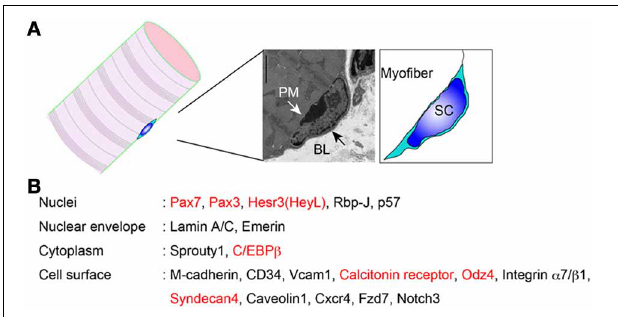
FIGURE 1 | Proteins expressed in quiescent muscle satellite cells. (A) Location of satellite cells. PM, plasma membrane; BL, basal lamina; SC, satellite cell. (B) Satellite cell molecules whose protein expressions are confirmed. Red indicates “quiescence